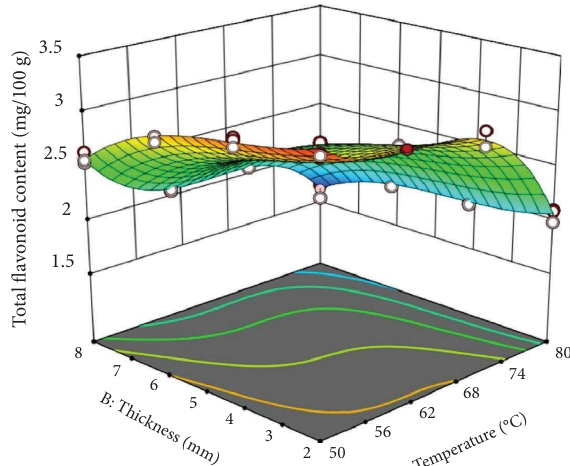
Figure 4: Infuence of tray-drying condition on the total favonoid content of green banana